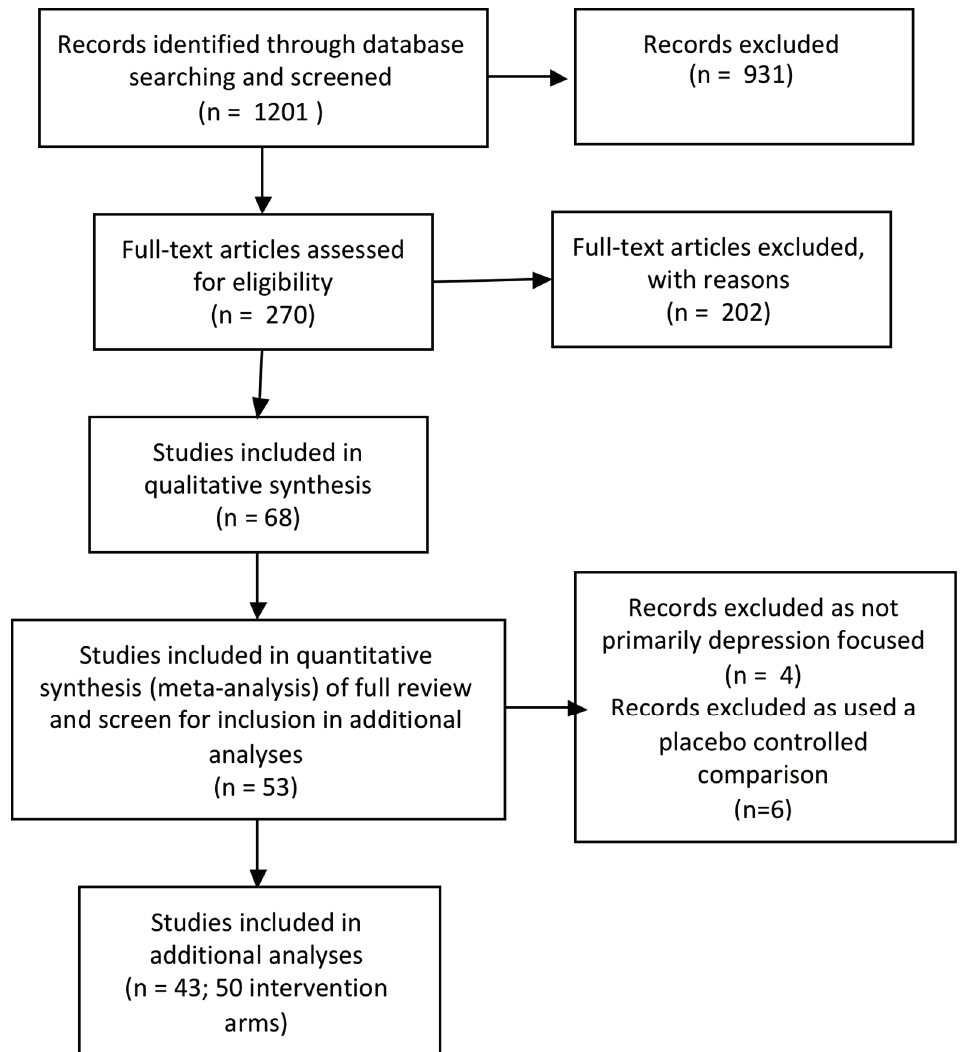
Figure 1. Flow diagram of